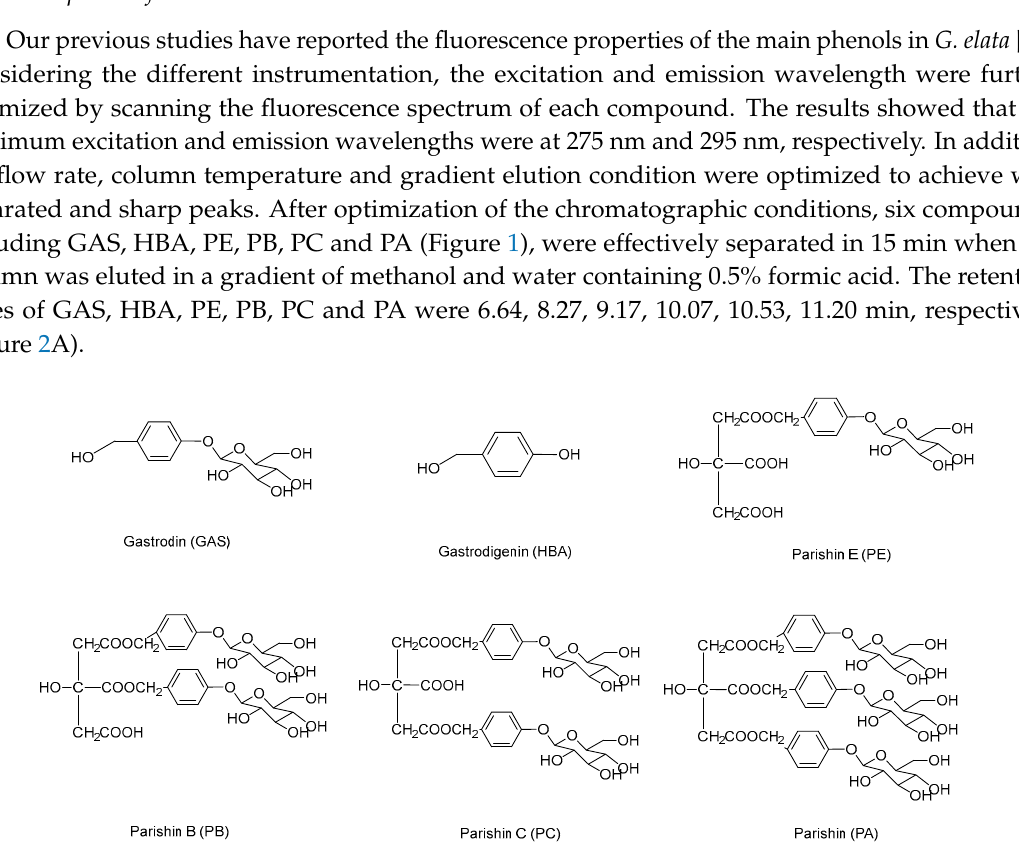
Figure 1. The structures of gastrodin (GAS), gastrodigenin (HBA), parishin E (PE), parishin B (PB), parishin C (PC) and parishin (PA).